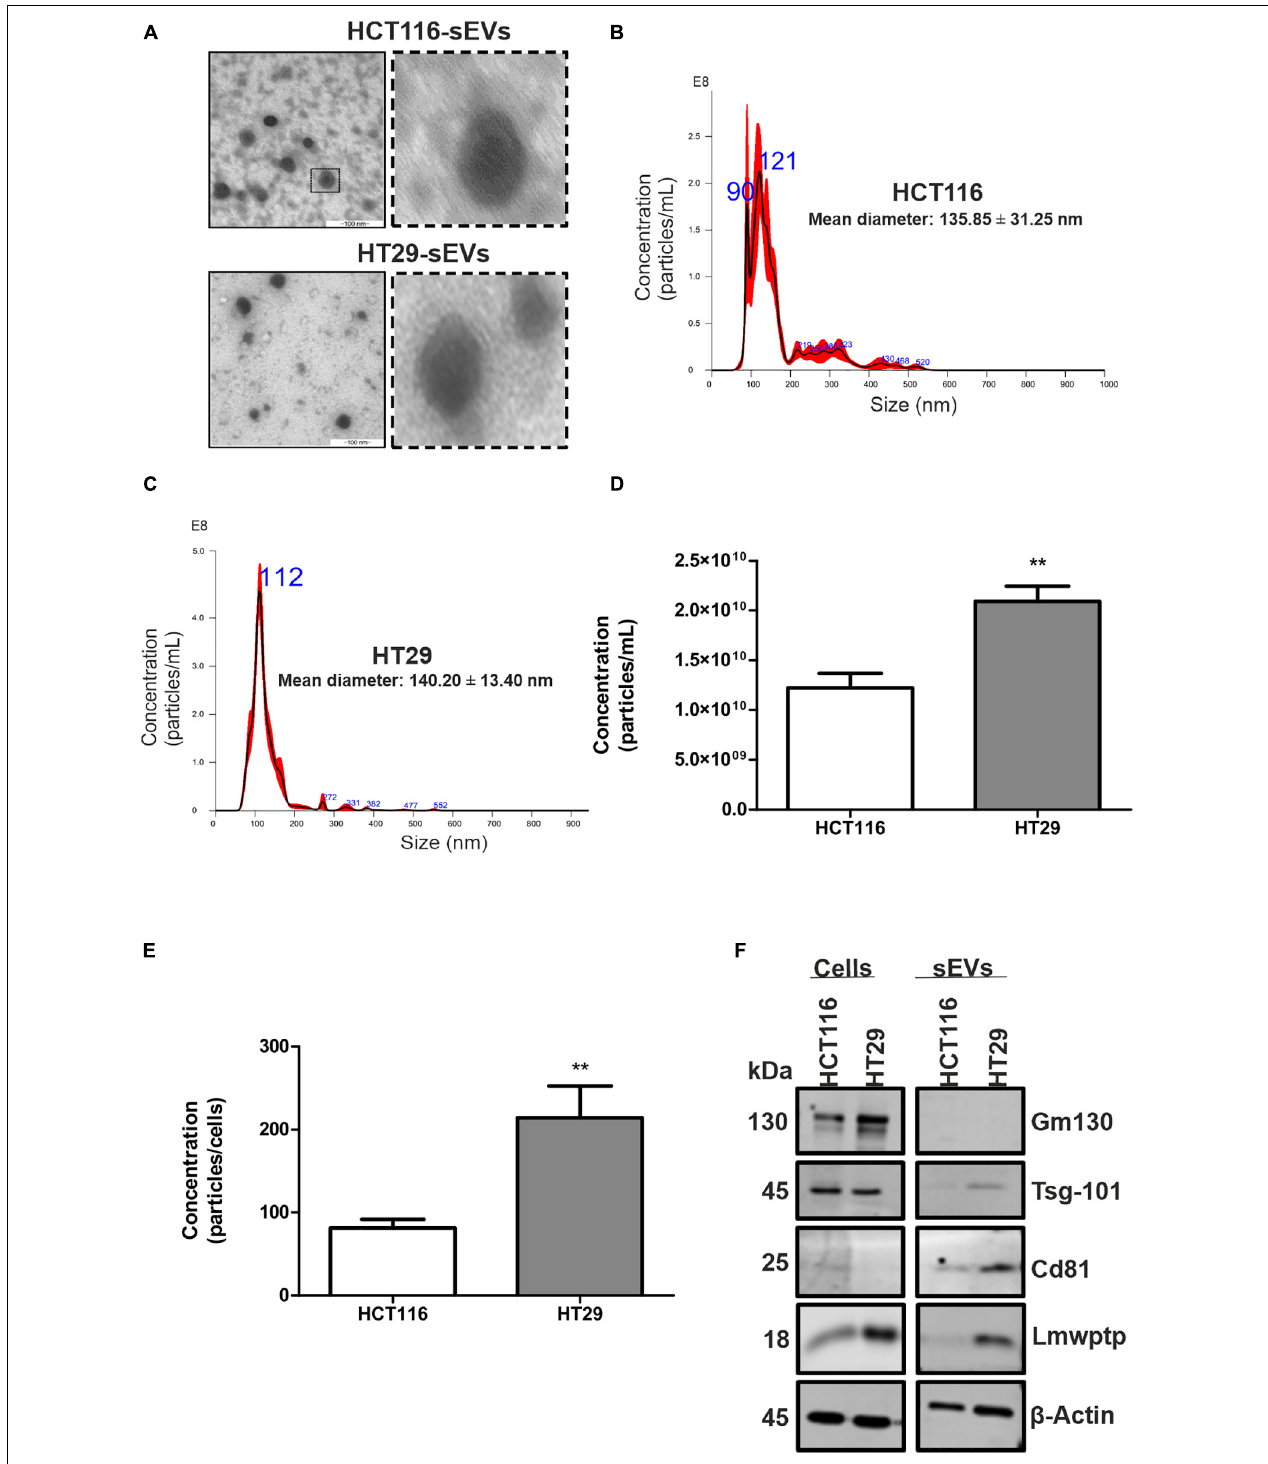
FIGURE 1 | Characterization of sEVs derived from HCT116 and HT29 cells. (A) Transmission electron microscopy micrographs of sEVs derived from HCT116 and HT29 cells depicting cup-shaped morphology. Scale bar: 100 nm. Representative graphs illustrating size distribution of sEVs from HCT116 (B) and HT29 (C) measured by nanoparticle tracking analysis. (D) Particle concentration measured by nanoparticle tracking analysis from HCT116- and HT29-derived sEVs. (E) Ratio of particle concentration and number of cells. (F) Representative images of Western blotting analysis from HCT116 and HT29 whole cell lysates and sEVs isolated from conditioned medium obtained from these cells, showing enrichment of EV markers and absence of non-EVs markers. Lmwptp is a cargo of HT29-derived sEVs ( N = 3). All values are displayed as mean ± SEM, where ** P < 0.01, assessed with Student t -test.